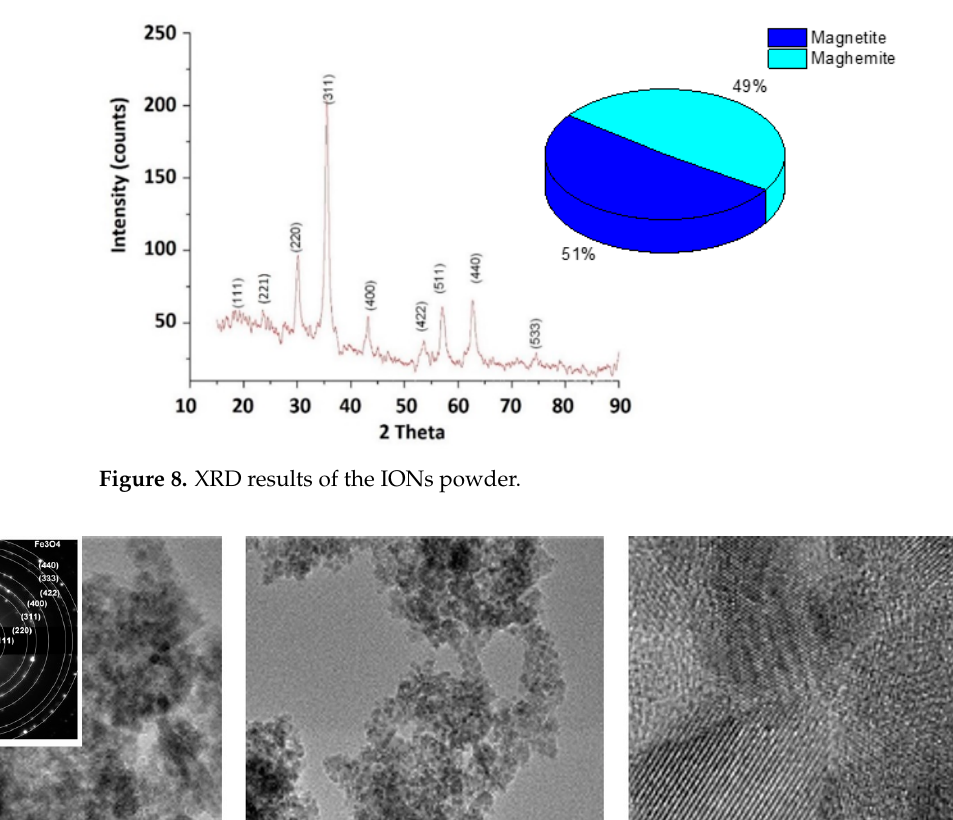
Figure 8. XRD results of the IONs powder.